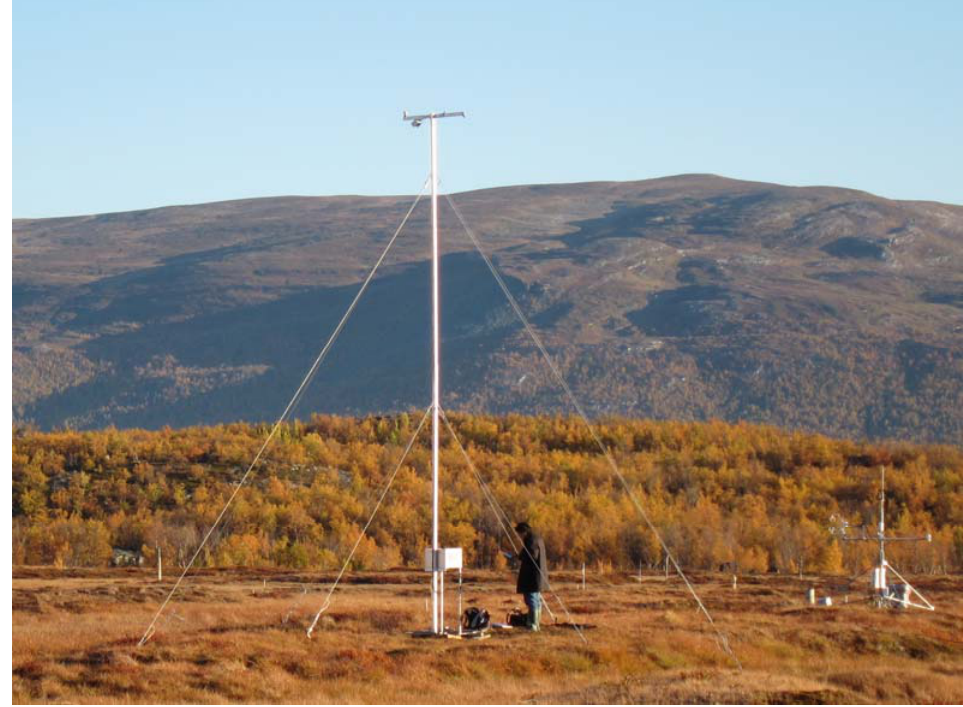
Figure 2. Photograph of the Stordalen mire site on September 18, 2010, showing the spectral mast (centre) and an eddy covariance flux tower (right). The oblique sensor views the ground tundra cotton-grass with a 55° off-nadir angle. The flux tower is measuring the carbon flux, and is operated by N. Roulet, McGill University, Montreal, Canada.